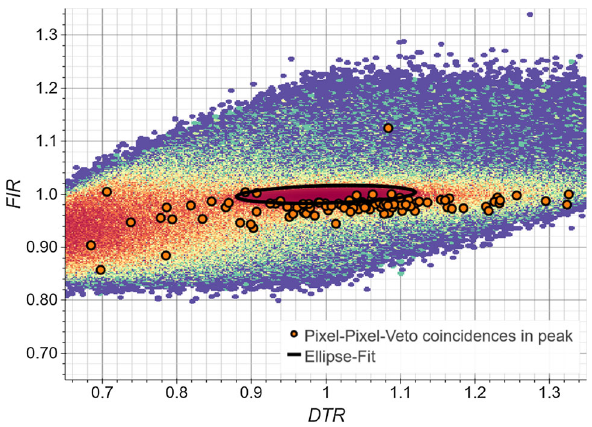
Fig. 11 The TFR parameter against the DTR parameter. The orange dots are the muon induced signals, mostly located in the surrounding of the ellipse. The pulses caused by the decay of 163 Ho are located inside the